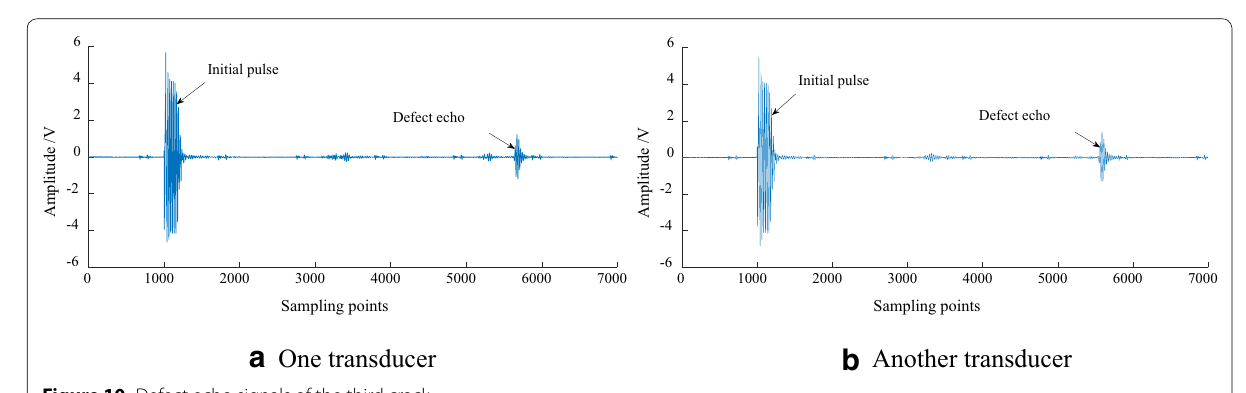
(3) The step distance of the transducer moving in the pipeline will affect the testing accuracy. (4) The volume of the cubical element for imaging will affect the accuracy of the crack parameters.